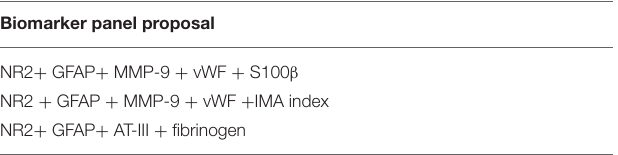
TABLE 2 | Proposal of biomarker panels for stroke recurrence. Biomarker panel